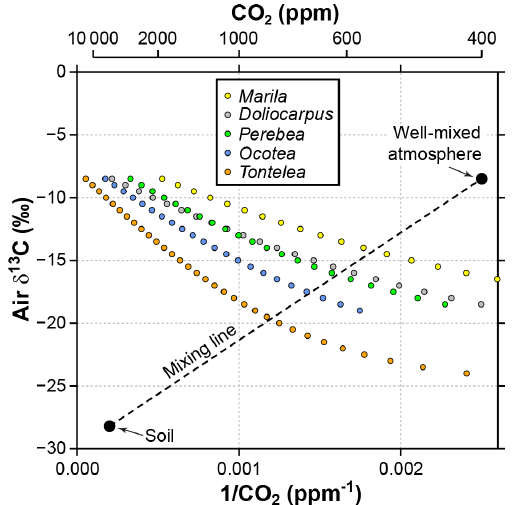
Figure 7. Sensitivity of estimated CO 2 in the Franks model to the δ 13 C of atmospheric CO 2 . Estimates come from leaves of five an- giosperm species that grew close to the forest floor in Parque Na- cional San Lorenzo, Panama. For each species, the step in δ 13 C air between estimates is 0.5‰. The dashed line is a two-end-member mixing model for CO 2 between the soil and well-mixed atmo- sphere. The intersection between the mixing model and the Franks model should correspond to the CO 2 concentration and δ 13 C air of the forest-floor